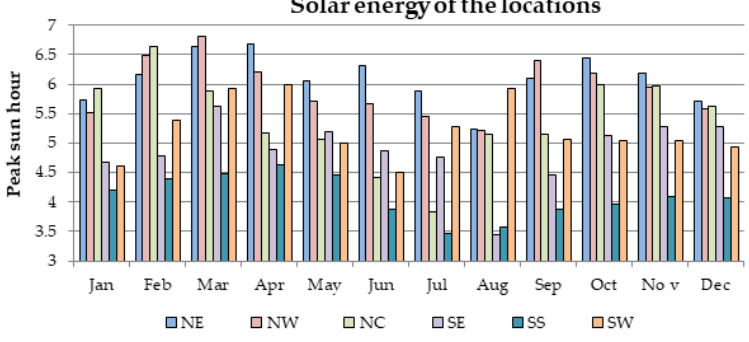
Figure 8. Peak sun hour of the locations